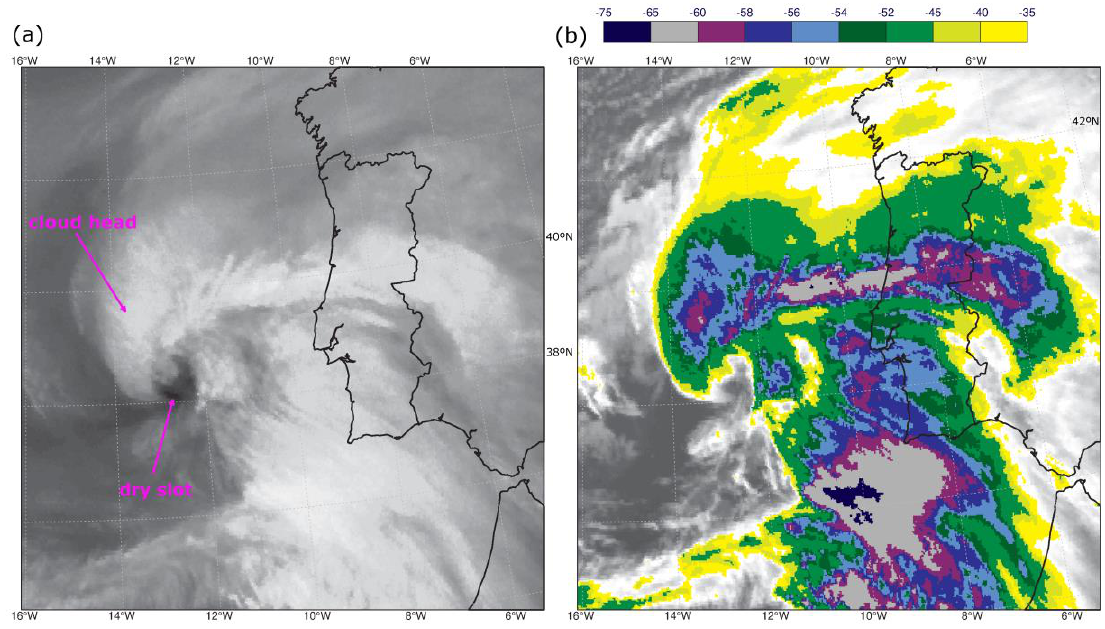
Figure 4. ( a ) MSG WV6.2 image and ( b ) IR10.8 brightness temperature (shaded from −5 to −75 °C) at 00:00 UTC on 23 December 2009. The cloud head and the dry slot are marked in ( a ).